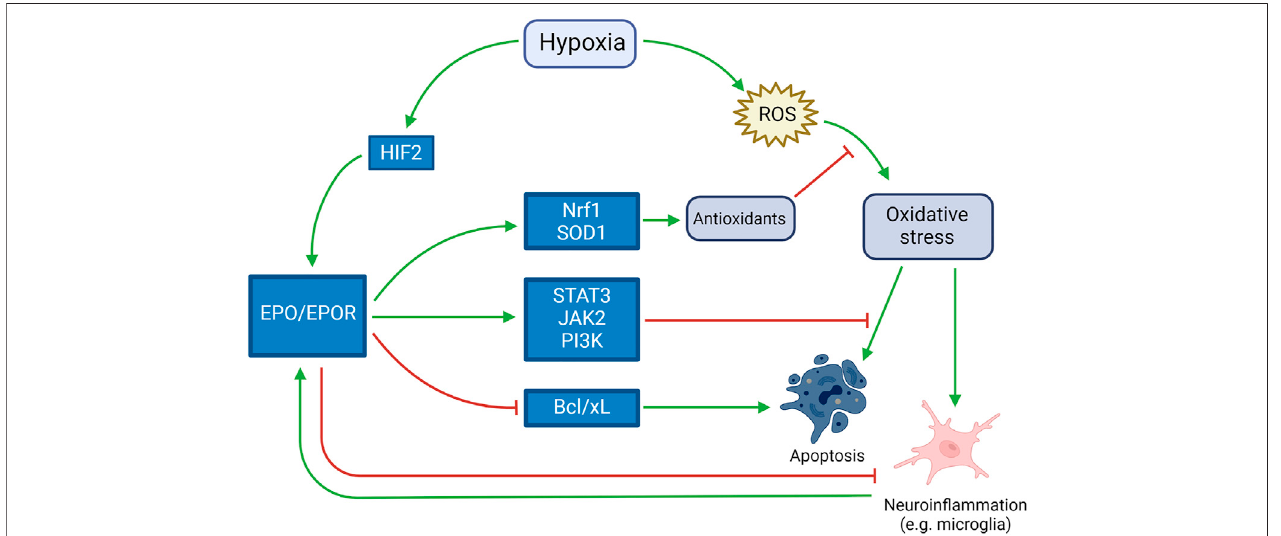
FIGURE 2 | Neuroprotective role of EPO in response to hypoxia. Activated by both hypoxia itself and the harmful mechanisms induced by hypoxia (such as neuroin fl ammation, apoptosis and oxidative stress), EPO counteracts such mechanisms by inducing antioxidant and antiapoptotic pathways and blocking pro- apoptotic